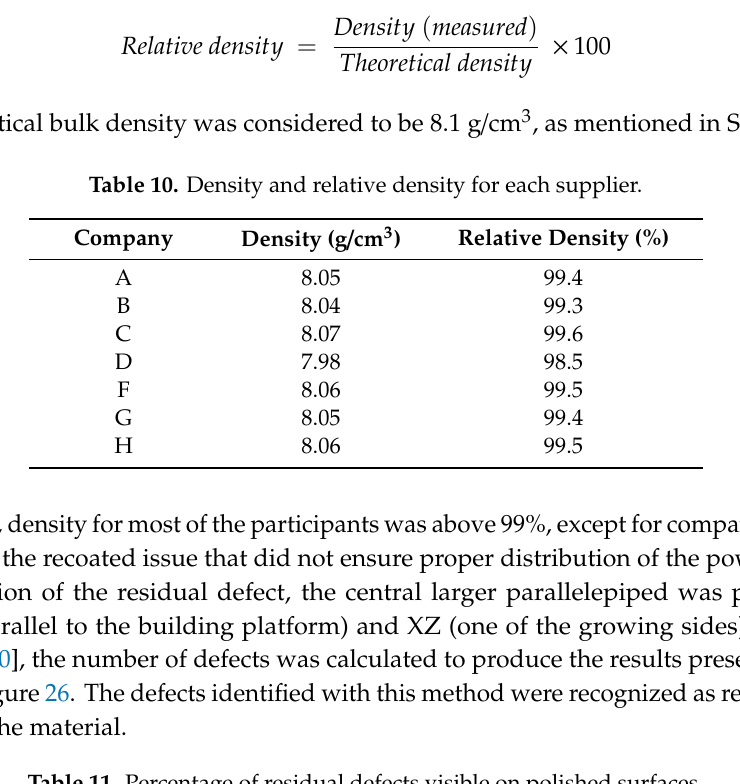
Table 11. Percentage of residual defects visible on polished